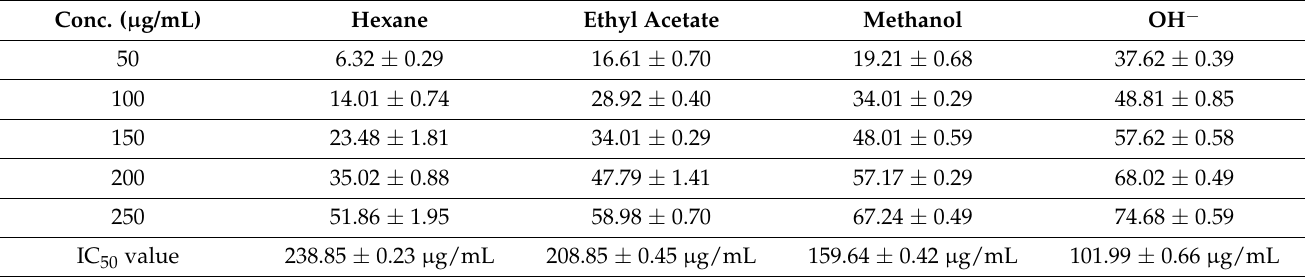
Table 6. Hydroxyl radical scavenging (OH − ) activity of different extracts of A. chasmanthum